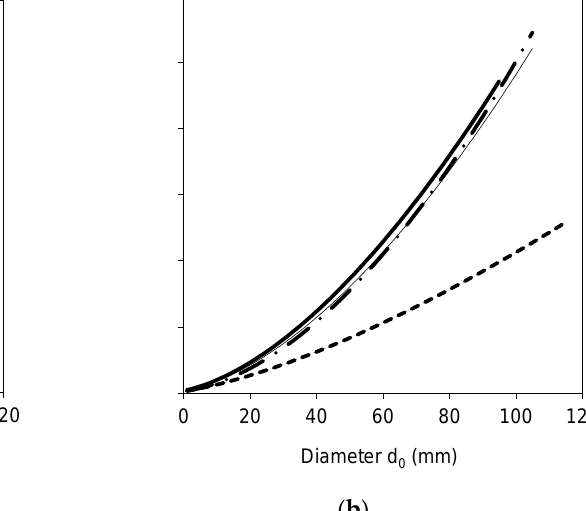
Figure 5. Species-specific models for the annual production of woody parts biomass, i.e., branches, stem and roots to- gether, against the initial diameter d 0 considering annual diameter increment of 5 mm ( a ) and 10 mm ( b ). Algorithms for calculation of the points on the curves are given in the Materials and Methods section (Equation (10)).